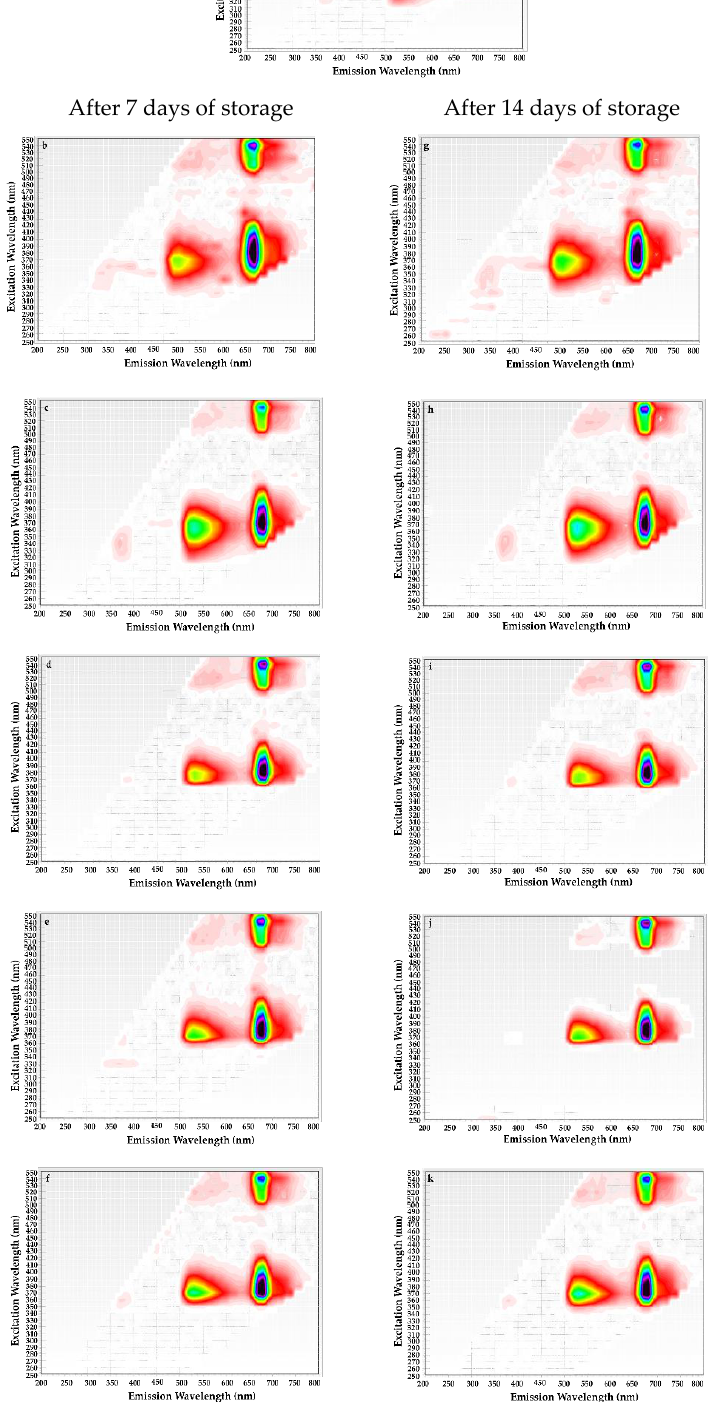
Figure 4. Excitation-emission matrices of fresh cold-pressed rapeseed oil (CPRO) ( a ), CPRO samples without and with film strips after 7 days ( b – f ) and 14 days ( g – k ) of storage: CRPO ( b , g ), CPRO + GEL-PVA ( c , h ), CPRO + GEL-PVA-ESA ( d , i ), CPRO + GEL-PVA-OSA ( e , j ), and CPRO + GEL-PVA- CSA ( f , k ).